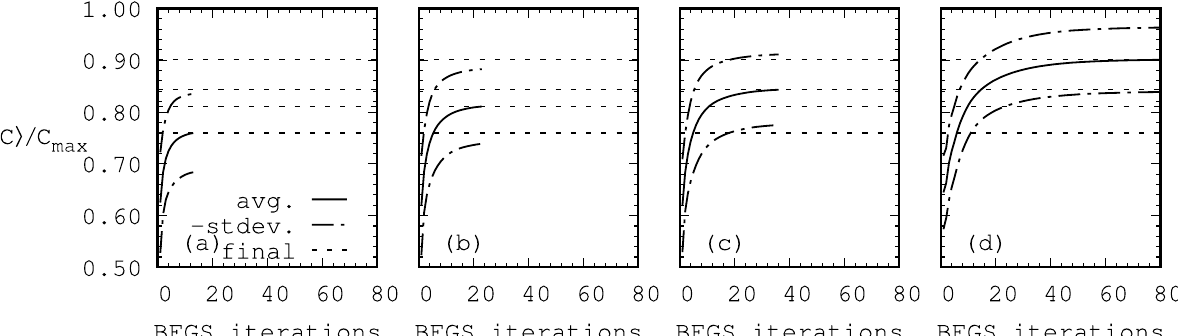
Figure 3. Typical behavior of the BFGS search algorithm for 100 random eight vertex graphs each with 100 random seeds in BFGS, for regular QAOA at ( a ) p Solid curves show averages over graphs and seeds, dashed-dotted lines show the average ± standard deviation and dotted lines show the final values. Each curve terminates at the average final iteration of the BFGS algorithm for the